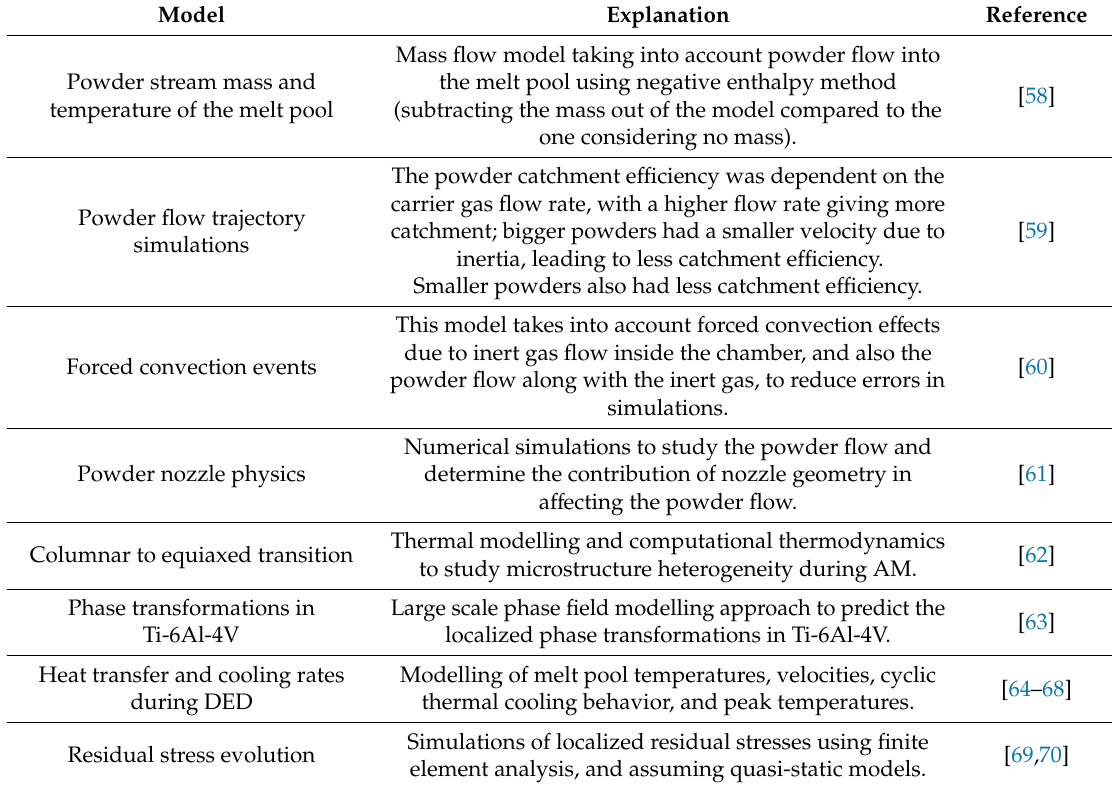
Figure 2. Schematic showing the thermal cycles for three consecutive layers during DED, and the corresponding peak temperatures for each layer. Table 2. Selected studies on the modelling efforts of various DED processes.